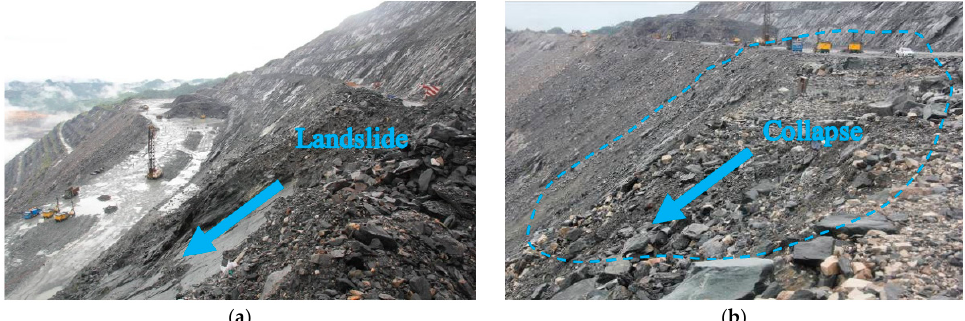
Figure 1. Landslides and collapses caused by rainfall. ( a ) local landslide; and ( b ) overall collapse Rainfall and slope sliding force in the mining area were monitored in real time to study the correlation between deformation and failure of the slope and rainfall in Nanfen open pit mine, as well as to predict the landslide trend. Statistical analysis was carried out on rainfall and significant changes in the slope sliding force at Nanfen open-pit mine, as shown in Table 1 and Figure 2. Changes in sliding force that are greater than or equal to 100 kN within 24 h are considered significant, and heavy rain is defined, as per the rainfall standard set by the Chinese meteorological department, as above 50 mm per day. Table 1. Statistics on rainfall and sliding force changes in Nanfen open-pit iron mine (From November 2010 to November 2012).